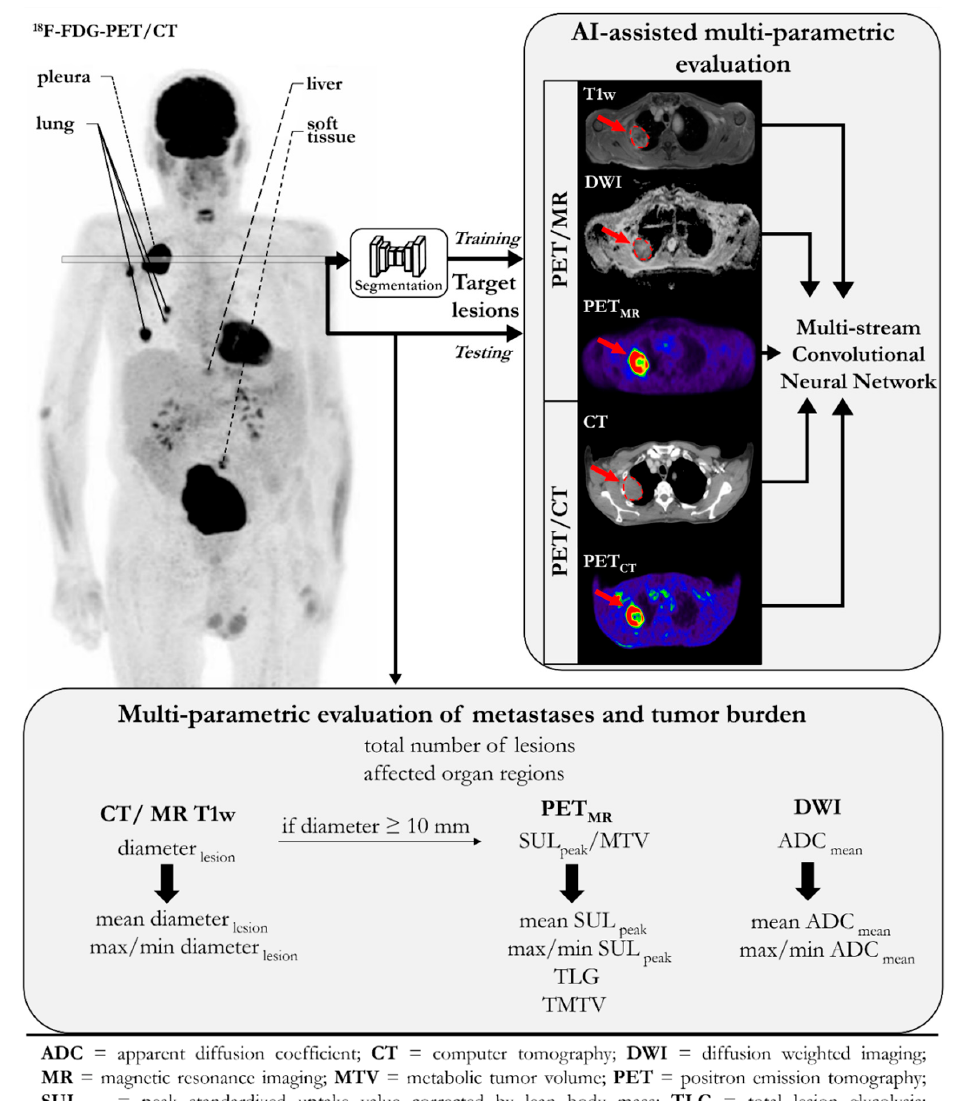
Figure 1. Overview of the multiparametric image analysis employing an AI-assisted evaluation and clinical evaluation to investigate the parametric dependency on treatment planning. An AI-assisted multiparametric evaluation was performed on automatically segmented (training) and manually selected (testing) target lesions (largest SULpeak and diameter) to support the treatment decision by grouping patients into low- and high-risk groups for unsuccessful immunotherapy